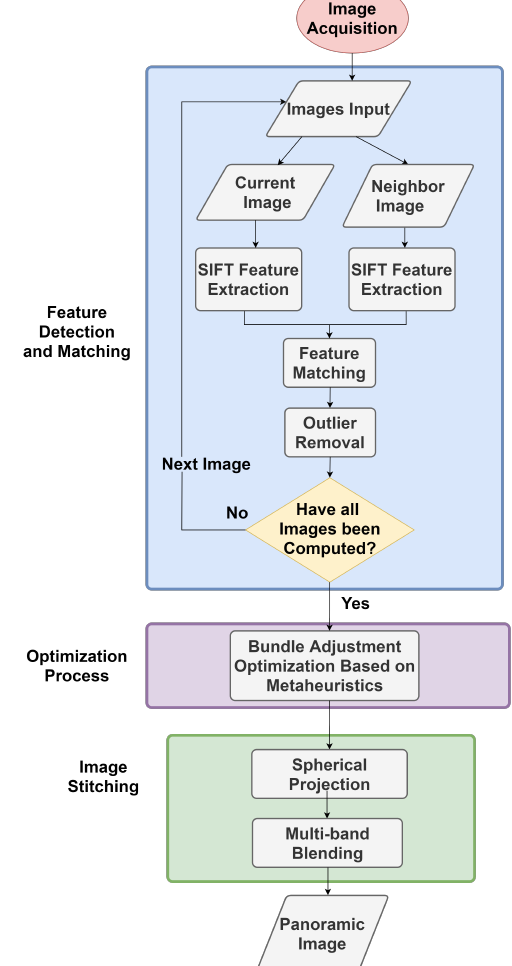
Figure 1. Flowchart of the Proposed